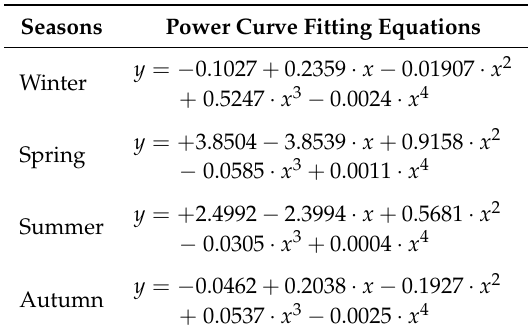
Table A1. Fourth-order polynomial equations.